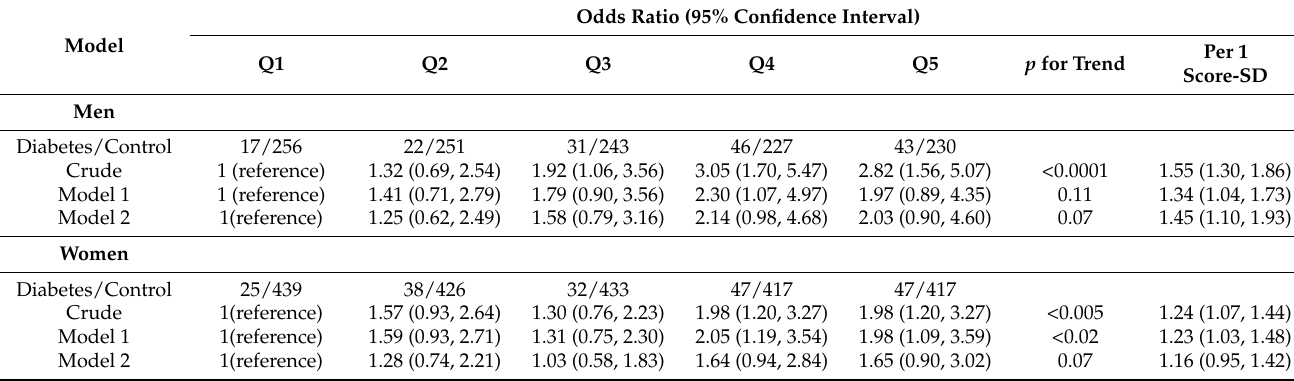
Table 3. Associations of the FLI-related and RRR-derived dietary pattern scores with type 2 diabetes among males and females 1